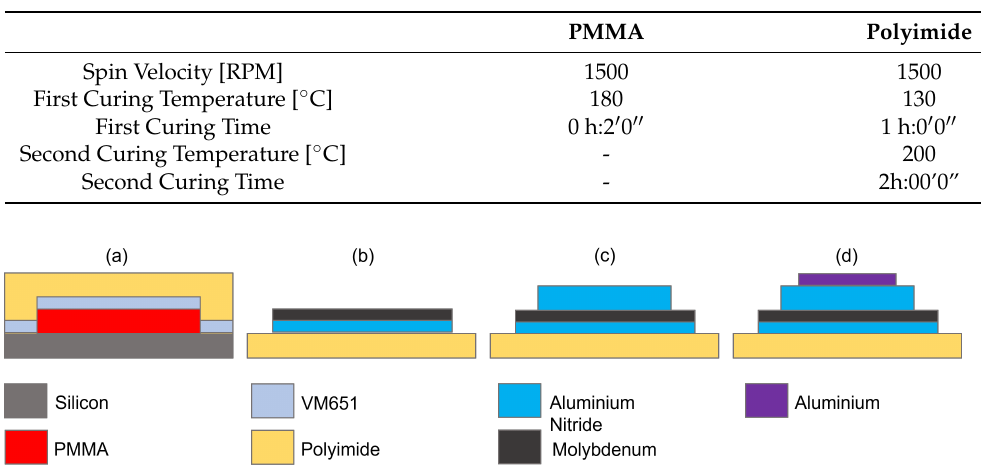
Table 1. Process parameters of the polyimide and sacrificial layer.